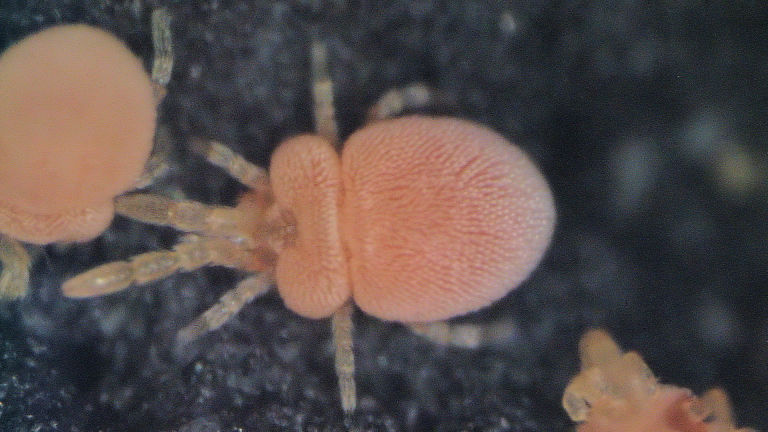
Leptotrombidium
russicum. Photo Joanna Mąkol.